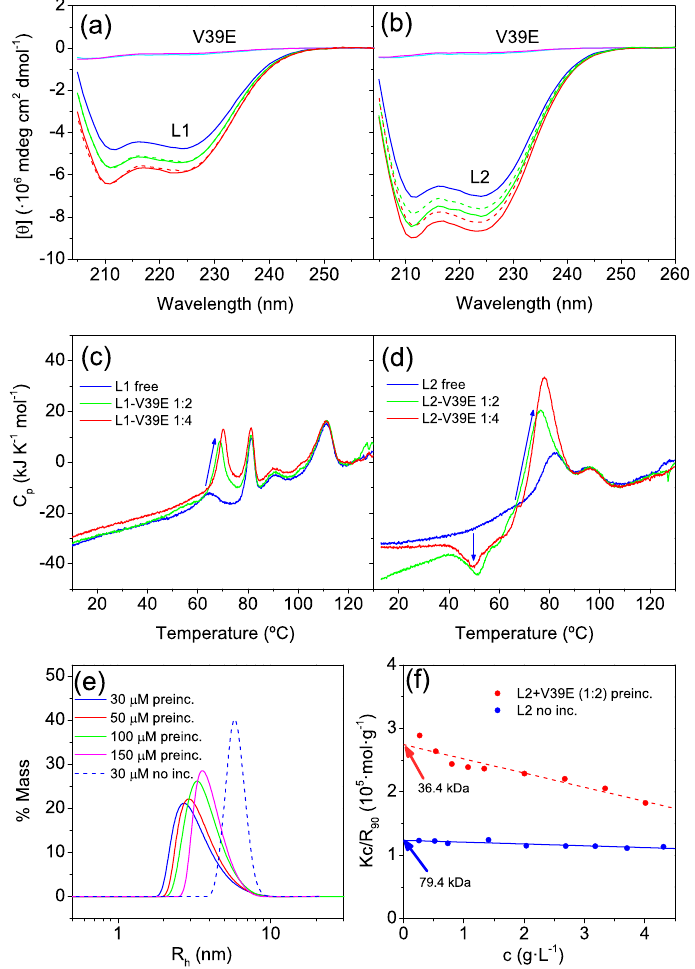
Figure 5. Effect of binding of the HR2-derived peptide V39E on the structure and stability of the L1 and L2 proteins. ( a , b ): Far-UV CD spectra of free L1 ( a ) and L2 ( b ) proteins (blue) and their mixtures with V39E peptide in 1:2 (green) and 1:4 (red) molar ratios. Spectra were recorded at pH 7.4 and 25 °C. The CD data were normalized per mole of protein monomer. The spectra of free V39E peptide measured at 30 μ M and 60 μ M under the same conditions are shown as cyan and magenta lines, respectively. The theoretical CD spectra calculated by the summation of spectra of the free proteins and the added free peptide are also indicated as dashed lines for comparison. ( c , d ): DSC scans meas- ured at pH 7.4 for the free L1 ( c ) and L2 ( d ) proteins at 30 μ M and in presence of V39E peptide at 1:2 and 1:4 molar ratios. The thermograms measured with the free V39E peptide under identical conditions were subtracted to remove its contribution to the heat capacity and observe the net effects of binding on the protein heat capacity. The blue arrows highlight the changes in the transitions produced by peptide binding. ( e ) Hydrodynamic radius distributions measured by DLS with L2:V39E mixtures at a molar ratio of 1:2 at varying protein concentrations as indicated. The mixtures were preincubated at 55 °C for 15 min before measurement at 25 °C. The equivalent measurement with a non-preincubated mixture is also shown with dashed line. ( f ) Debye plot corresponding to SLS measurements at 25 °C with L2:V39E mixtures of varying concentrations preincubated at 55 °C for 15 min (red). The Debye plot corresponding to free L2 is shown in blue for comparison. The binding of the V39E peptide to the two protein variants was also studied by ITC (Figure 6). The ITC thermogram measured at 25 °C for the titration of L1 with V39E showed sharp negative peaks, indicating an exothermic interaction (Figure 6a). The ITC thermogram measured for L2 with the same V39E peptide also showed exothermic bind- ing, but the peaks were broader and recovered the baseline slowly as a result of slow heat